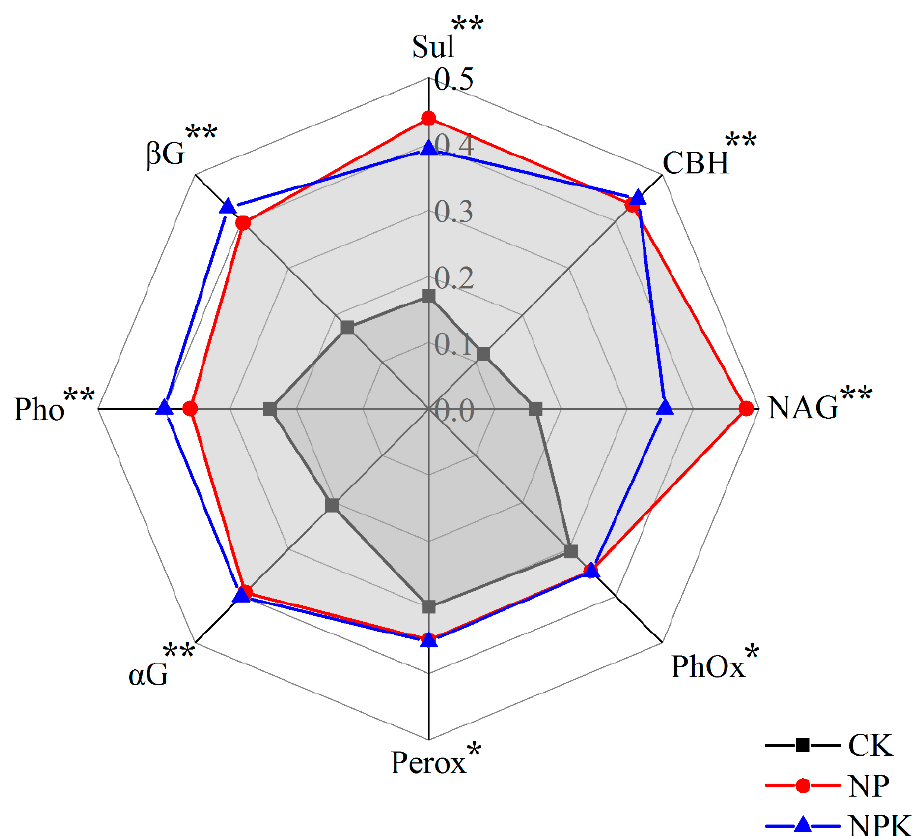
Figure 2. Radar graph of the relative responses of enzymatic activities to long-term fertilization treatments (CK, no fertilizer; NP, nitrogen and phosphorous fertilizer; NPK, nitrogen, phosphorus, and potassium fertilizer). Asterisks indicate significant differences among fertilizer treatments (* p < 0.05; ** p < 0.01). Pho: phosphatase; α G: α -glucosidase; β G: β -glucosidase; CBH: cellobiohydrolase; NAG: N-acetyl-glucosaminidase; Sul: sulfatase; Perox: peroxidase; PhOx: phenol oxidase.